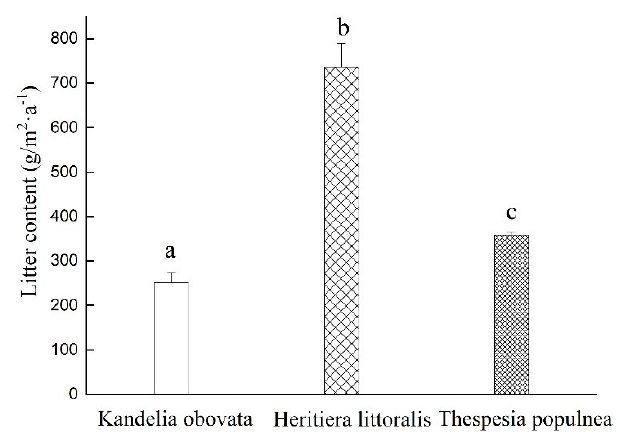
Figure 3. A comparison of litter yield among the three mangrove species.